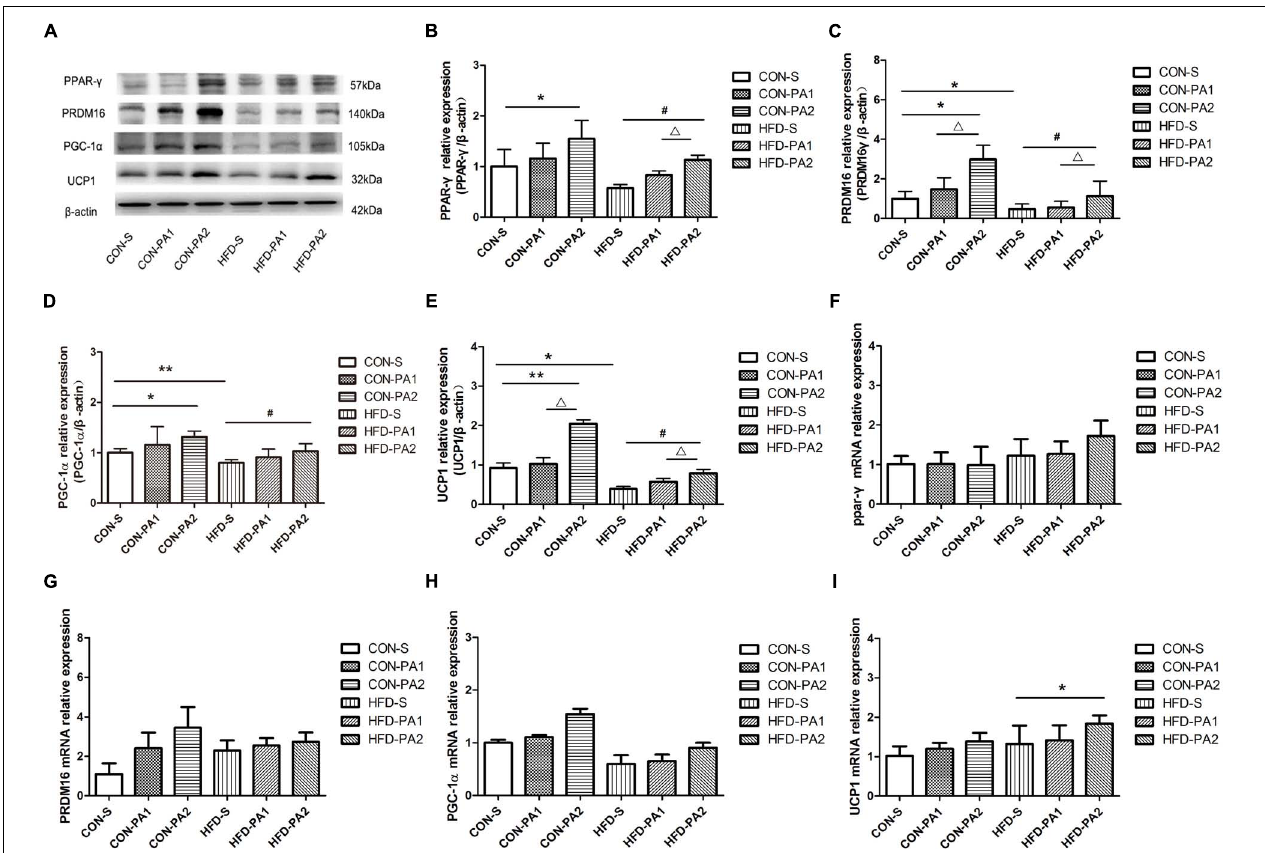
FIGURE 5 | Expression levels of browning-related proteins and genes in mice WAT. (A–E) Western blot analysis of protein PPAR- γ , PRDM16, PGC-1 α , and UCP1 in subcutaneous adipose tissues. (F–I) Relative expression analysis results of PRDM16, PPAR- γ , PGC-1 α , and UCP1 genes, respectively. Compared with the CON-S group, * P < 0.05 and ** P < 0.01; compared with the HFD-S group, # P < 0.05 and ## P < 0.01; comparison between exercise groups (CON-PA1 vs. CON-PA2, HFD-PA1 vs. HFD-PA2), (cid:49) P < 0.05 and (cid:49)(cid:49) P <